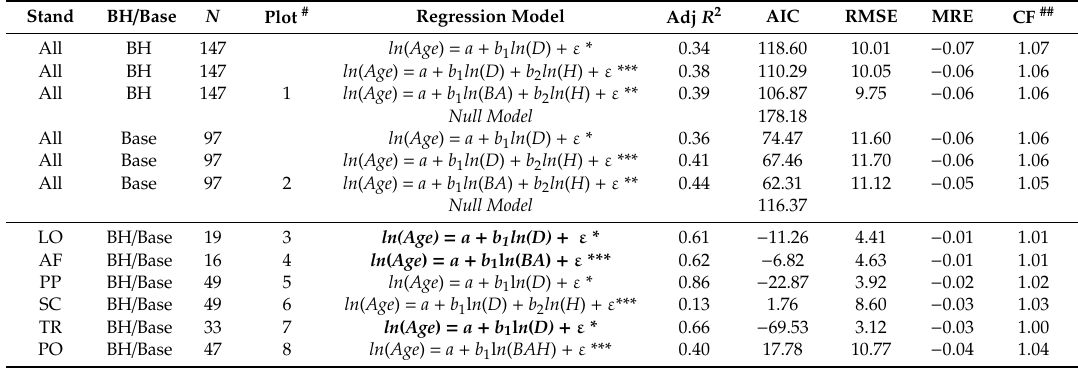
Table 2. Selected allometric equations relating tree age and dendrometric parameters tested for 147 L. azorica (Seub.) Franco trees sampled at breast height (BH), for 97 L. azorica trees sampled at base (Base), and for each stand of L. azorica in S ã o Miguel Island. Allometric models: * [54]; ** [2]; *** Current study. Regression model equation (see Tables S1–S7); Stand code (see Table 1). N (number of samples). Plot # (see Figure 9). Adjusted determination coe ffi cient (Adj R 2 ); Akaike Information Criterion (AIC); Root Mean Square Error (RMSE); Mean Relative Error (MRE); Correction Factor (CF); Diameter (D); Tree Height (H); Basal Area (BA). This is a selection of the best models. See Tables S1–S7 for the full set of tested models.